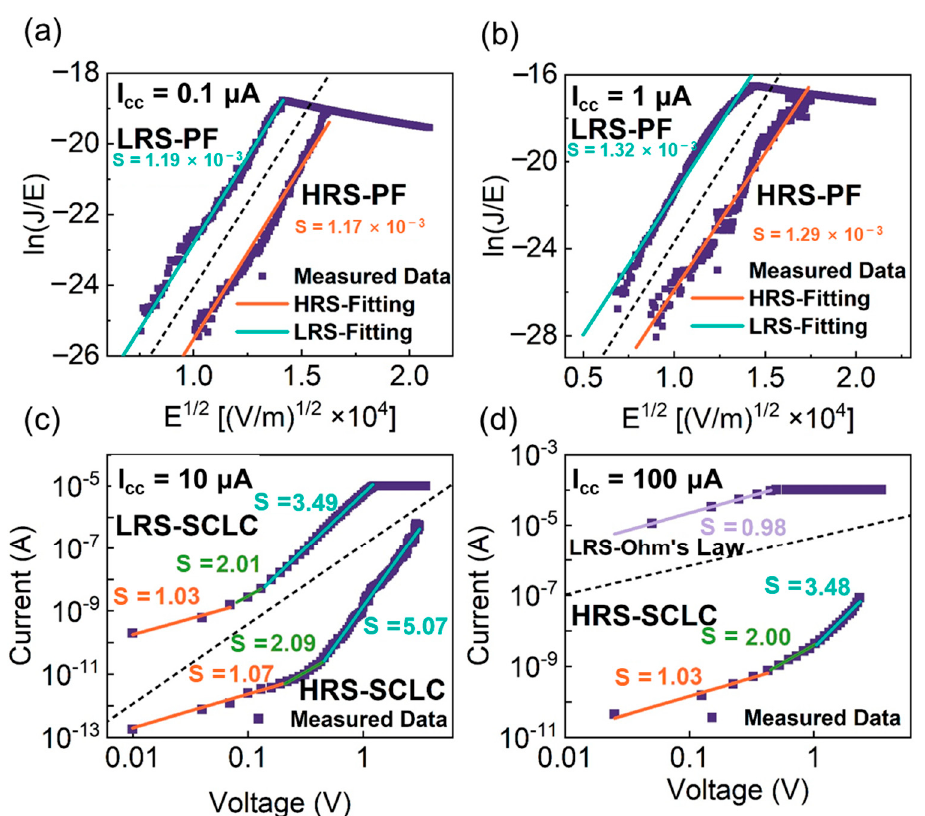
Figure 4. Comparison of experimental and theoretical calculation of the I–V curves for Al/a– SiN x O y :H/P + –Si device in HRS and LRS with I cc of ( a ) 0.1 nA ( b ) 1 µA ( c ) 10 µA as well as ( d ) 100 µA SiN x O y :H/P + –Si device in HRS and LRS with I cc of ( a ) 0.1 nA ( b ) 1 µ A ( c ) 10 µ A as well as ( d ) 100 µ A based on P-F model, SCLC model and Ohm’s law. based on P-F model, SCLC model and Ohm’s